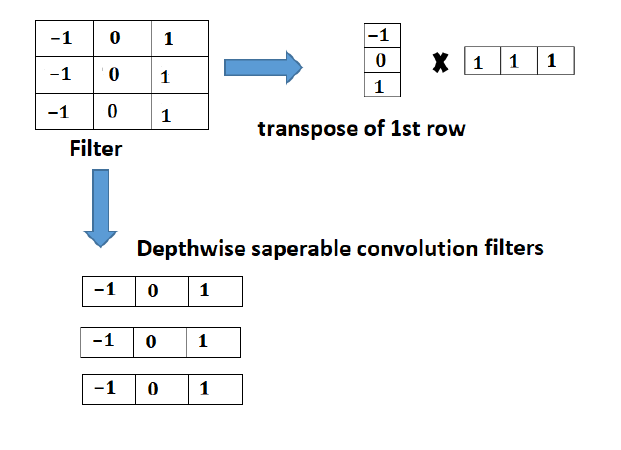
Figure 7. Depth-wise separable